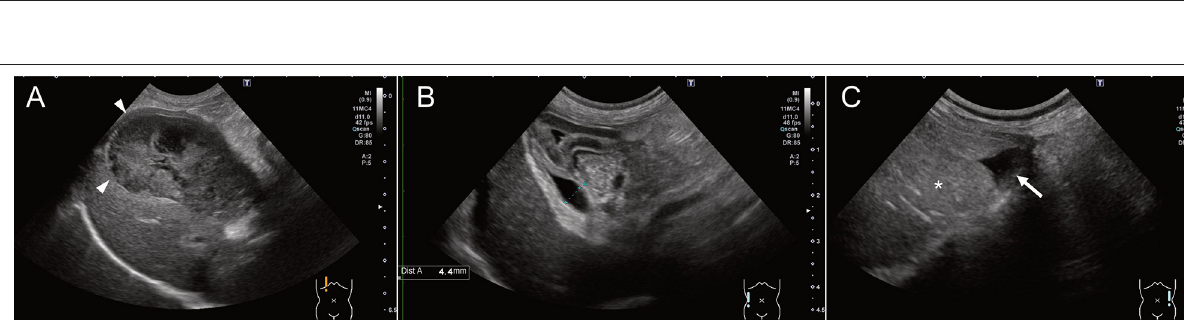
FIGURE 1 | Three thoracic and abdominal radiographs obtained from a dog with biloma on initial presentation. The right crus of the diaphragm was found to have been cranially displaced by one intercostal space relative to the left crus in the ventrodorsal view of the thorax [ (A) ; white arrow-head]. The pylorus of stomach was displaced caudally in the lateral (B) and ventrodorsal (C) radiographic views of the abdomen (black arrow-head).